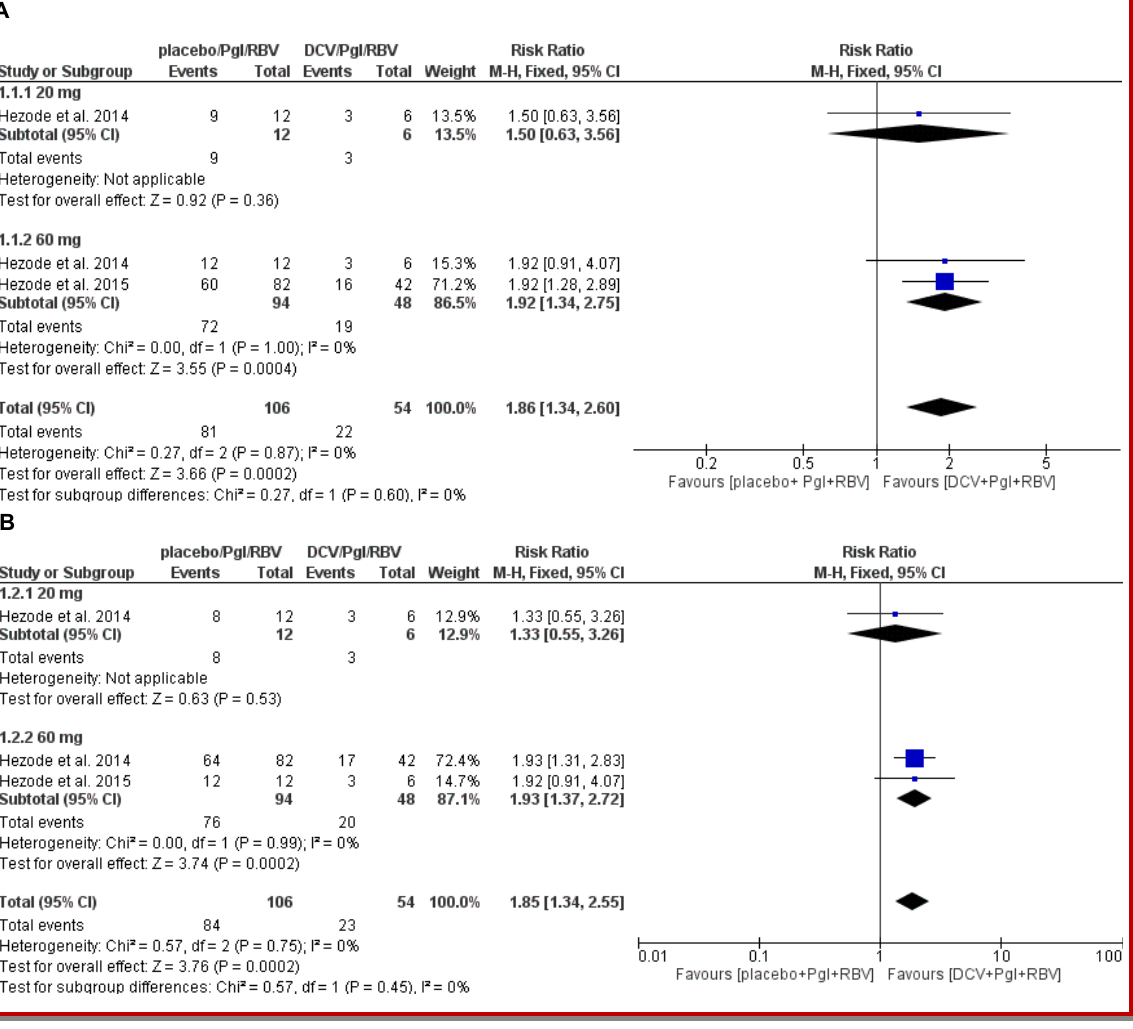
Figure 2: Forest plots comparing the dual and triple regimens in terms of SVR at 24 weeks (A) and 24 weeks